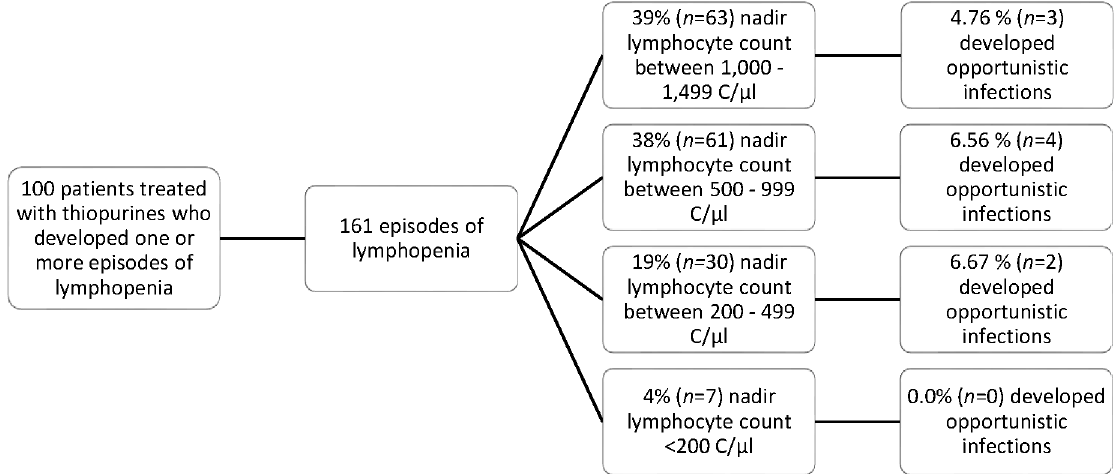
Fig 2. Severity of lymphopenia. Thiopurine-associated episodes of lymphopenia and opportunistic infections, subdivided according to severity of lymphopenia.